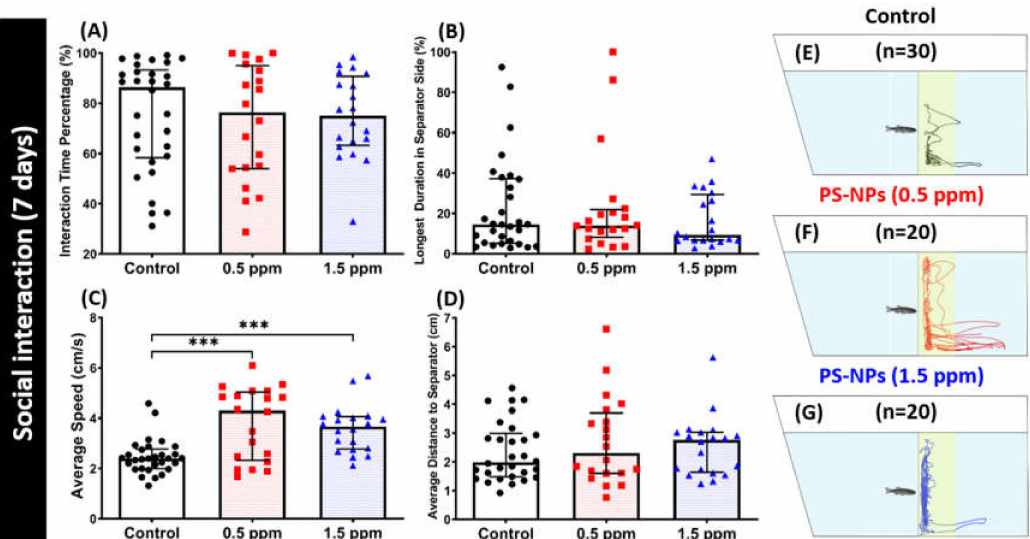
Figure 5. Social interaction behavior endpoints comparisons between control and polystyrene nanoplastics (PS-NPs)-exposed zebrafish groups after a ~7-day exposure. ( A ) Interaction time percentage, ( B ) longest duration in the separator, ( C ) average speed, and ( D ) average distance to separator side were analyzed for social interaction assay. The 1 min. locomotion trajectories for the control, 0.5 and 1.5 ppm PS-NPs exposed fish in mirror biting tests were presented in E , F , G , respectively with the yellow-colored zone as the conspecific interaction region. The data are expressed as the median with interquartile range and were analyzed by a Kruskal-Wallis test, which continued with Dunn’s multiple comparisons test as a follow-up test ( n = 30 for control; n = 20 for each PS-NPs-exposed